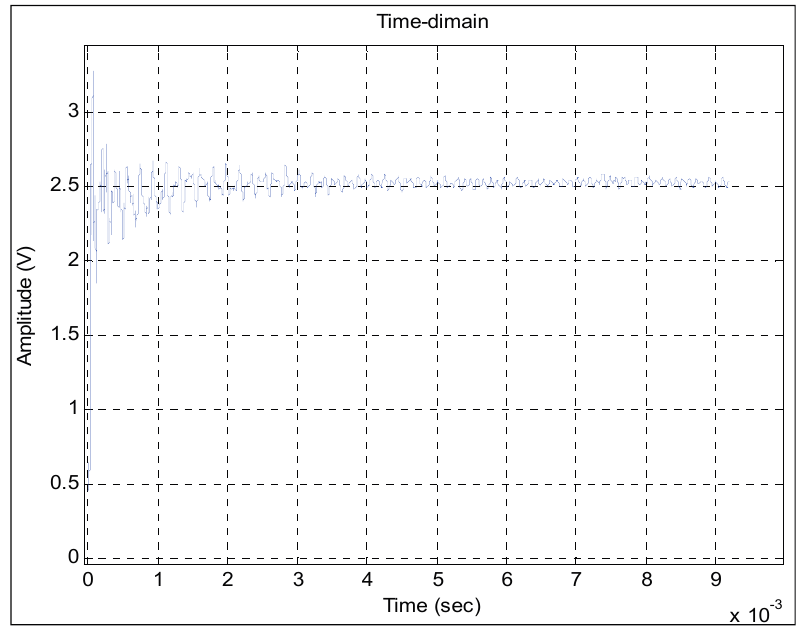
Figure 8. Filtering result obtained by the Kalman method.